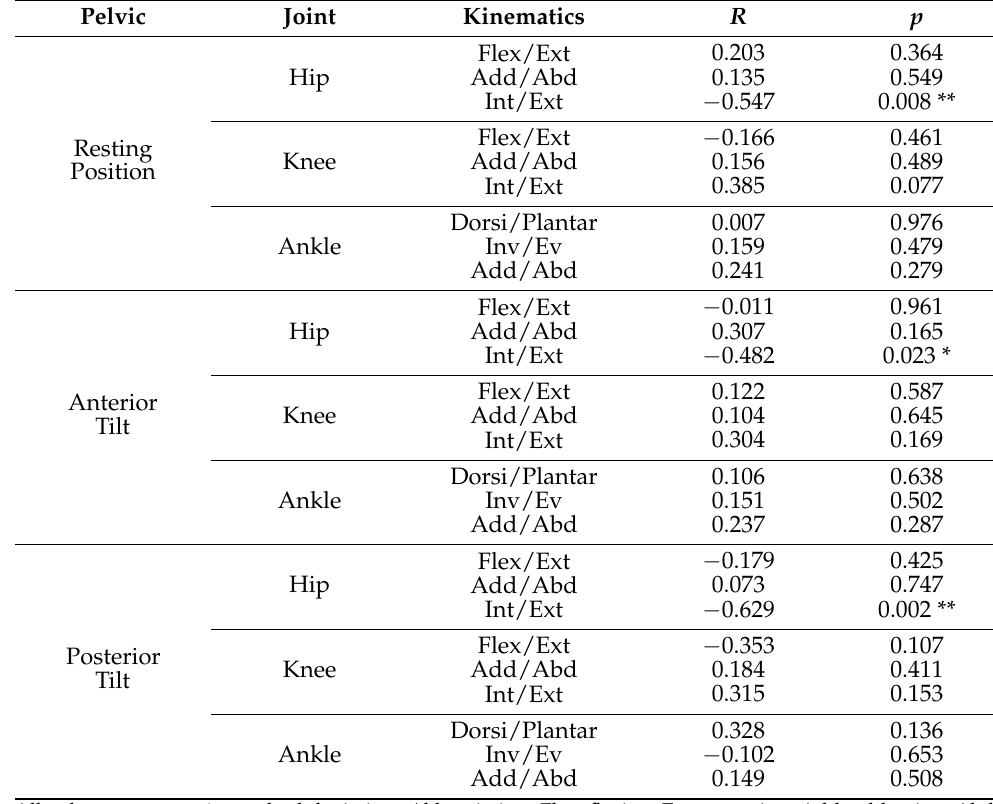
Table 3. Pearson correlation between Q-angle and lower-limb kinematic variables in each